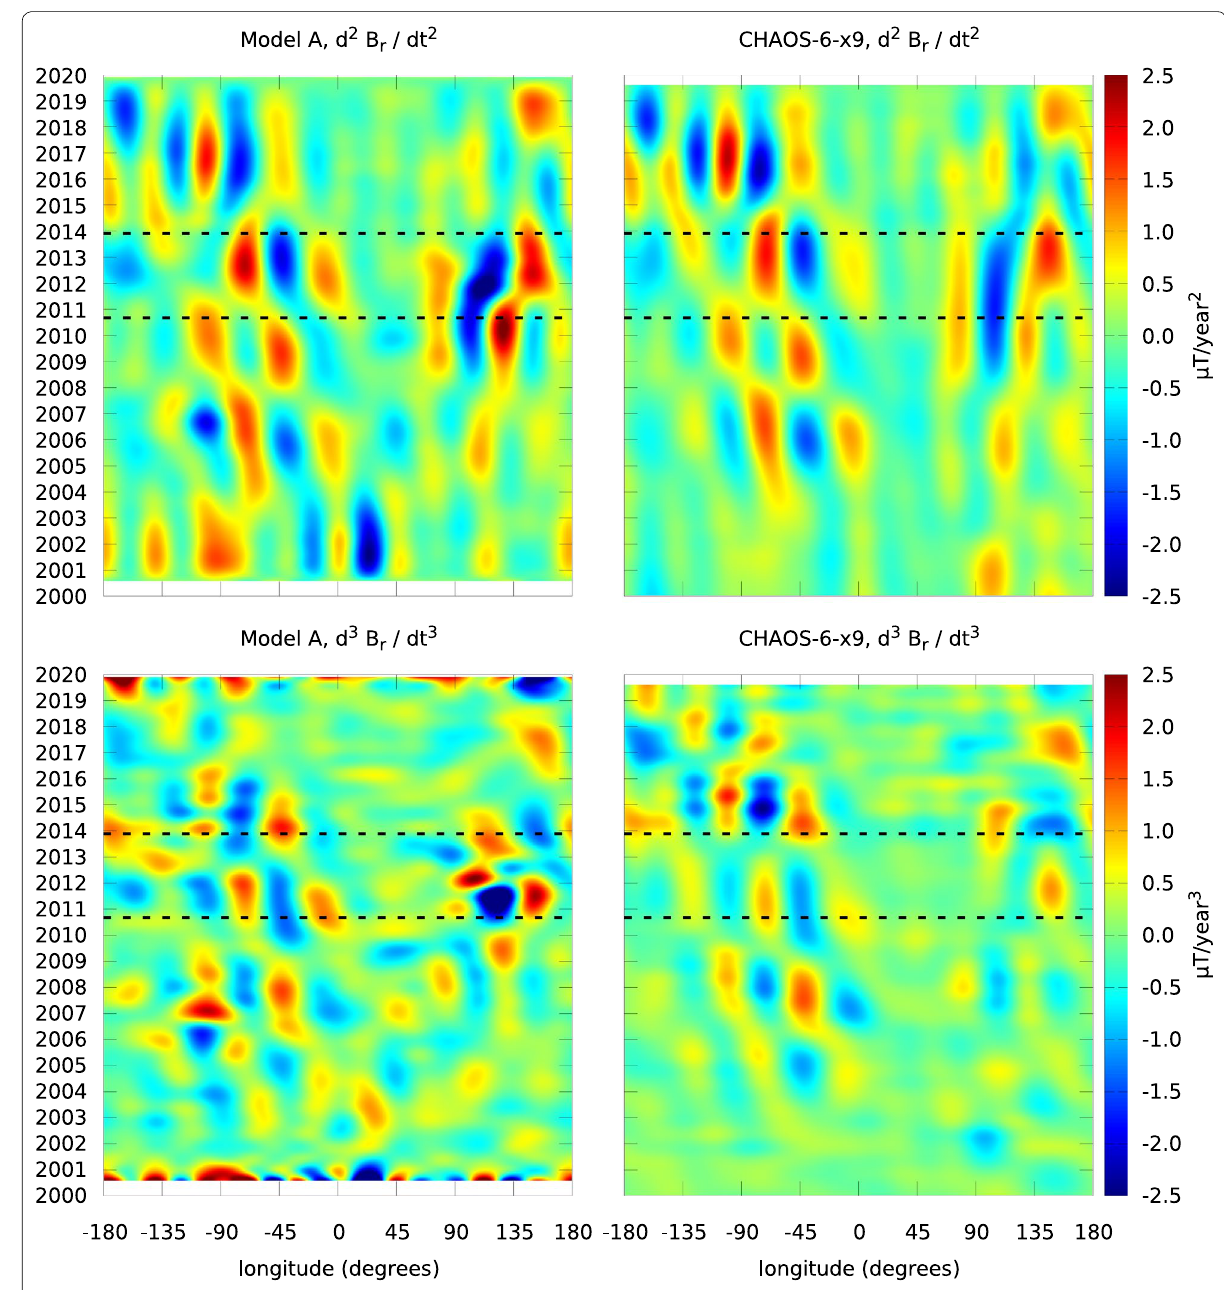
Fig. 11 Time/longitude maps of secular acceleration in the B r component (top row) and third time derivative of B r (bottom row) at the core mantle boundary along the geographic equator. Maps are generated using spherical harmonic degrees 1 to 10 for Model A (left column) and CHAOS-6-x9 (right column). Dashed lines indicate gap period between CHAMP and